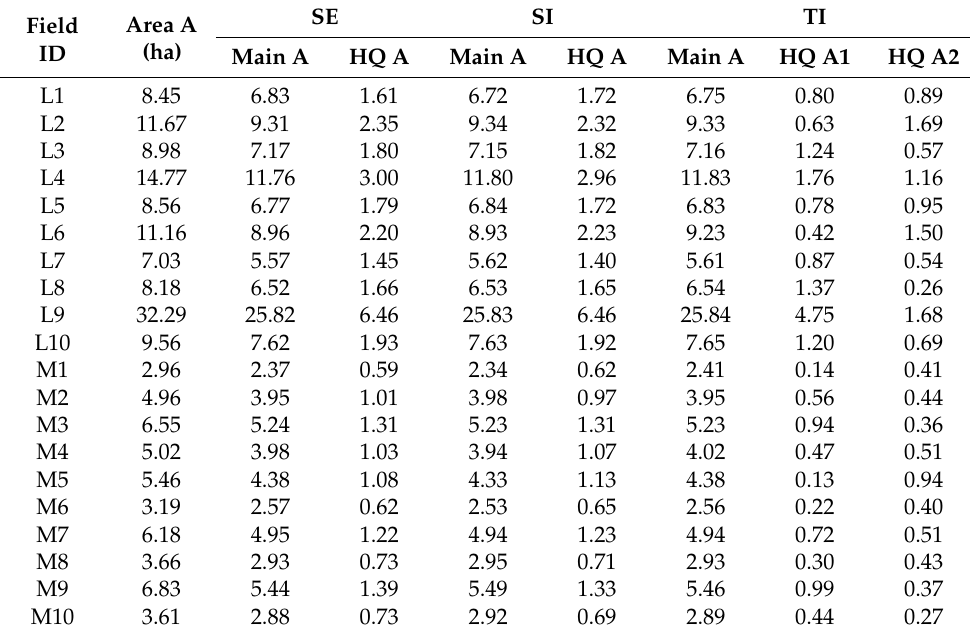
Table 1. Field areas in hectares for the set of fields and the high-quality areas (HQ A) and remaining areas (Main